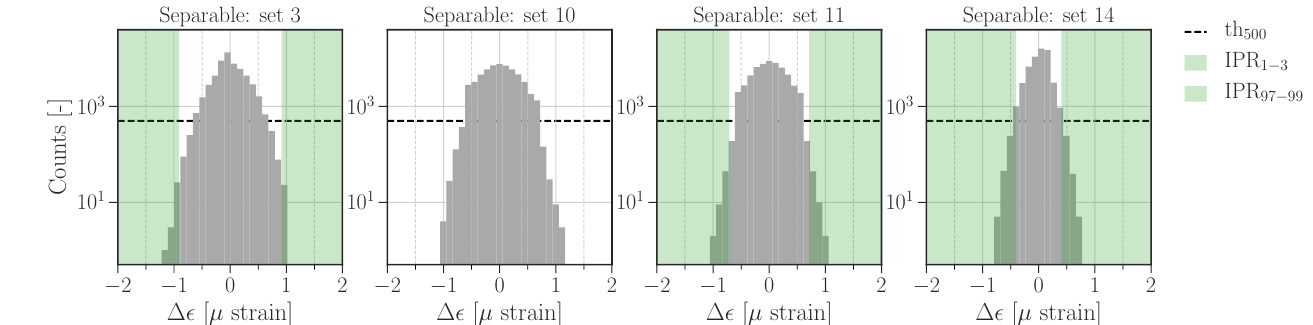
Figure A3. Zoom in on histogram of sample wise strain difference signals for four separable cases, including inter percentile ranges (IPR). The distribution of the nominal samples of set 14 is represen- tative for the other data sets which which are not shown in this